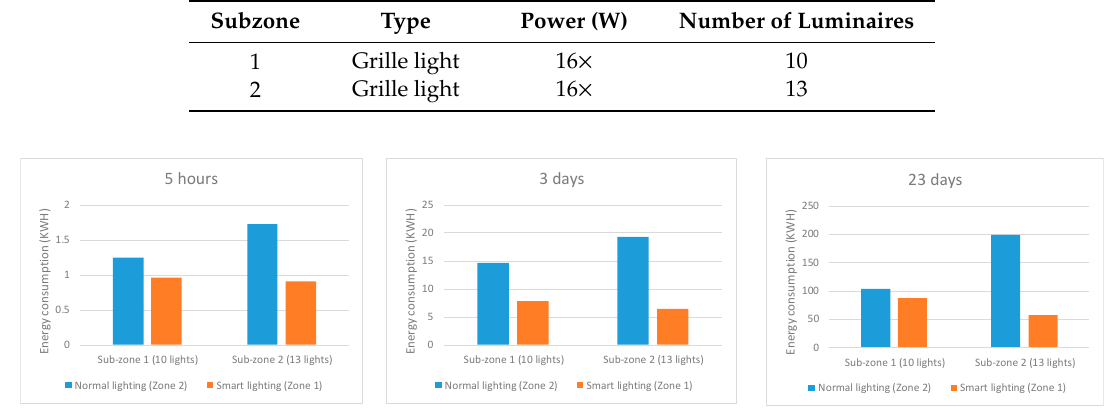
Figure 12. Comparison of energy consumption. Table 4. Specifications of the light-emitting diodes (LED) luminaires in the comparison experiment. Table 5. Energy consumption and energy